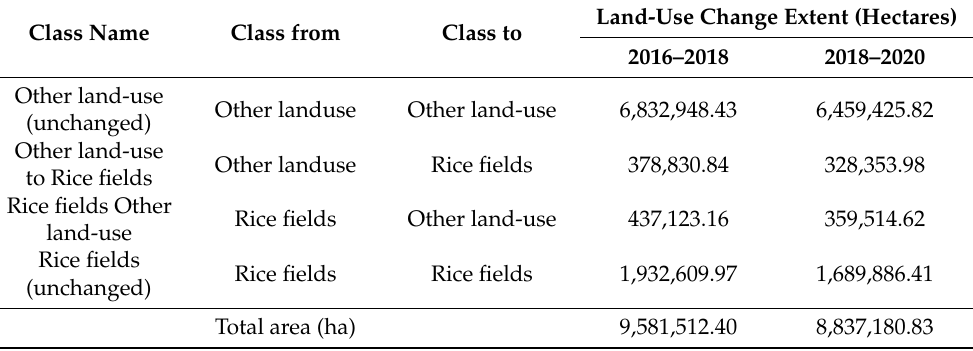
Table 5. Results of change detection analysis for 2016–2018 and 2018–2020 time